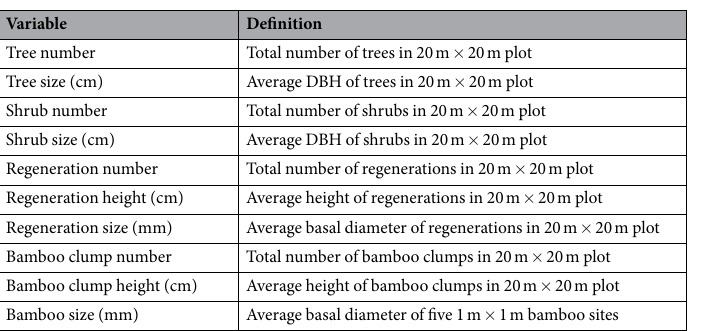
Table 5. Definition of the variables used in this